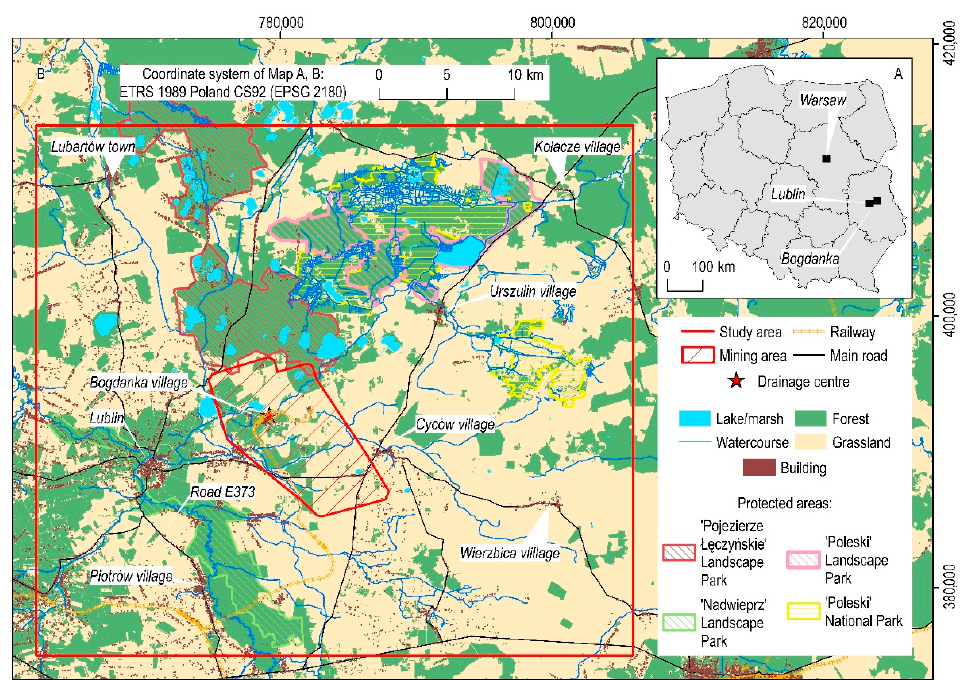
Figure 1. ( A ) The location of the study area on a map of Poland; ( B ) the main built-up areas, surface infrastructure and land use in the study area, the distribution of surface water reservoirs, significant rivers, minor watercourses and protected areas. Source of data: the Main Office of Geodesy and Cartography of Poland, the Polish Geological Institute-National Research Institute and Open Street Map contributors.